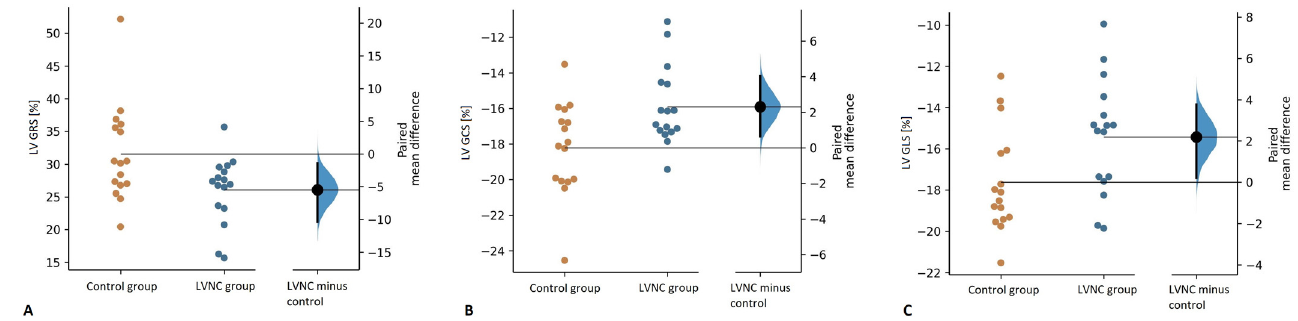
Figure 4. Comparison of left ventricular global radial strain (GRS) ( A ), global circumferential strain (LV GCS) ( B ), and global longitudinal strain (LV GLS) ( C ) between the control and the LVNC group.